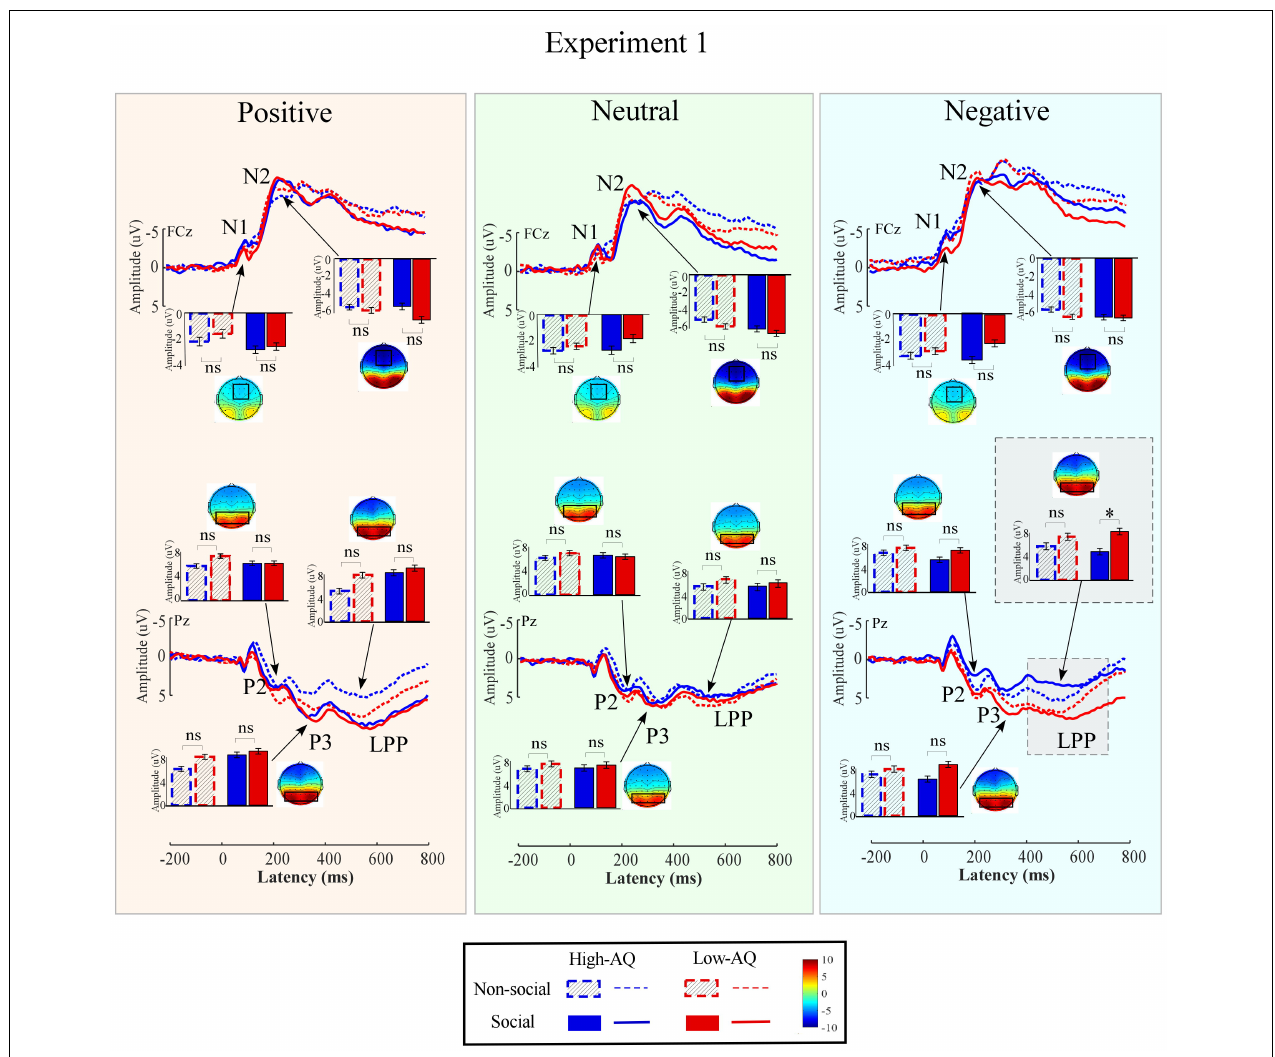
FIGURE 5 | Relationship between AQ scores and ERP amplitudes. The correlation between the LPP amplitudes in response to social-negative pictures in Experiment 1 and AQ scores of the High-AQ (blue dots) and Low-AQ (red dots) groups are shown in the top panel . The correlation between the LNC amplitudes in response to social-negative audio recordings and AQ scores of the High-AQ (blue dots) and Low-AQ (red dots) groups in Experiment 2 are shown in the bottom panel . Data in the figure were calculated using the Pearson correlation coefficient.